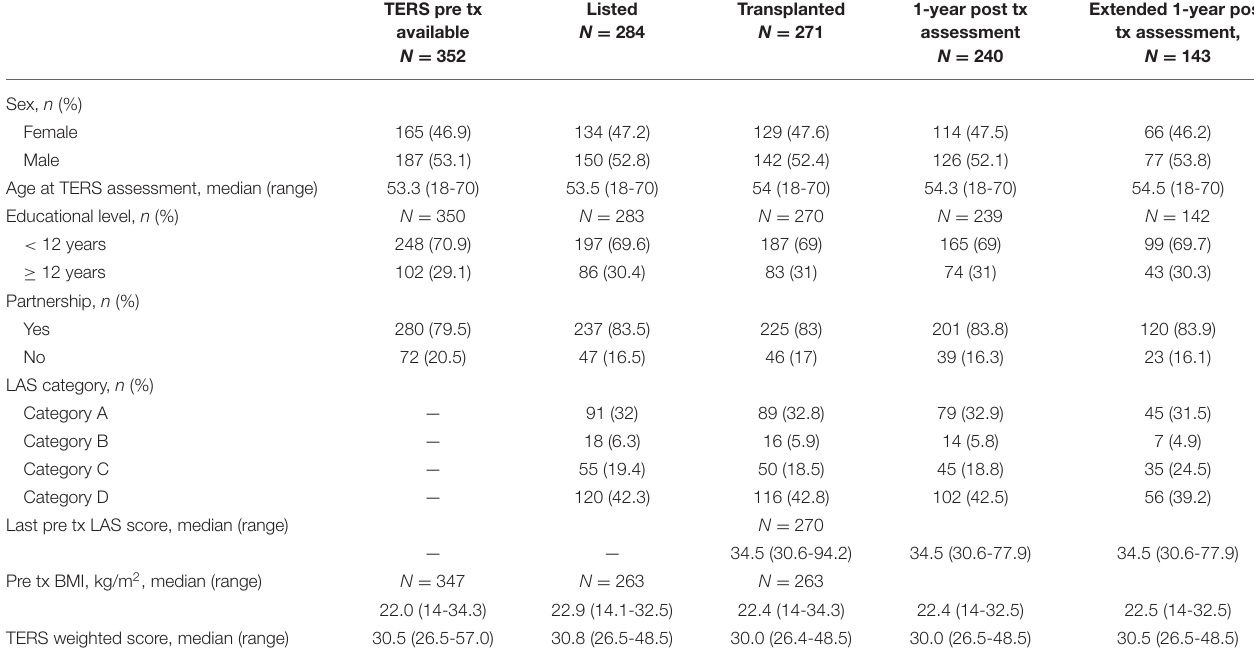
TABLE 1 | Baseline characteristics of different samples.